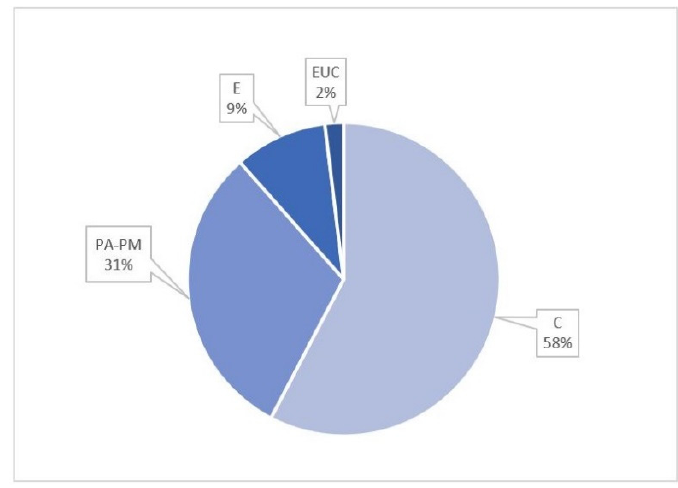
Figure 6. Percentage of projects per addressed target group. (C — consumers; PA-PM — public administrations and policy makers; E — entrepreneurs; and EUC — energy utility companies). Image elaborated by the authors.